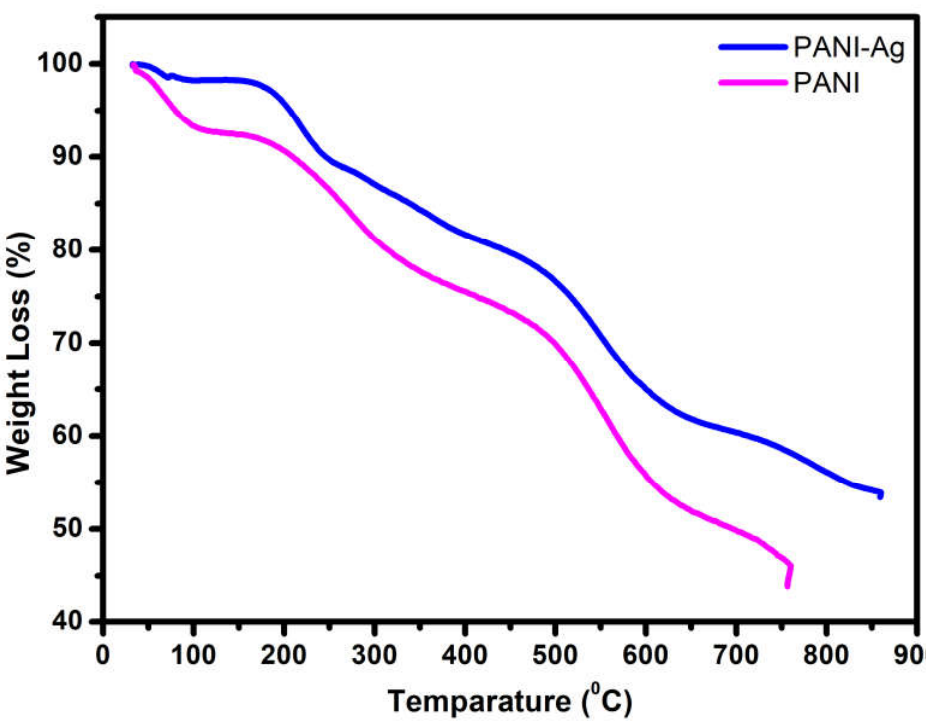
Figure 7. TGA thermograms of PANI and the PANI-Ag composite.